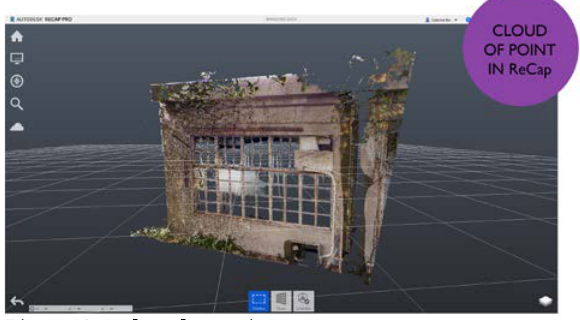
Figure 16: Isolate element in Recap.